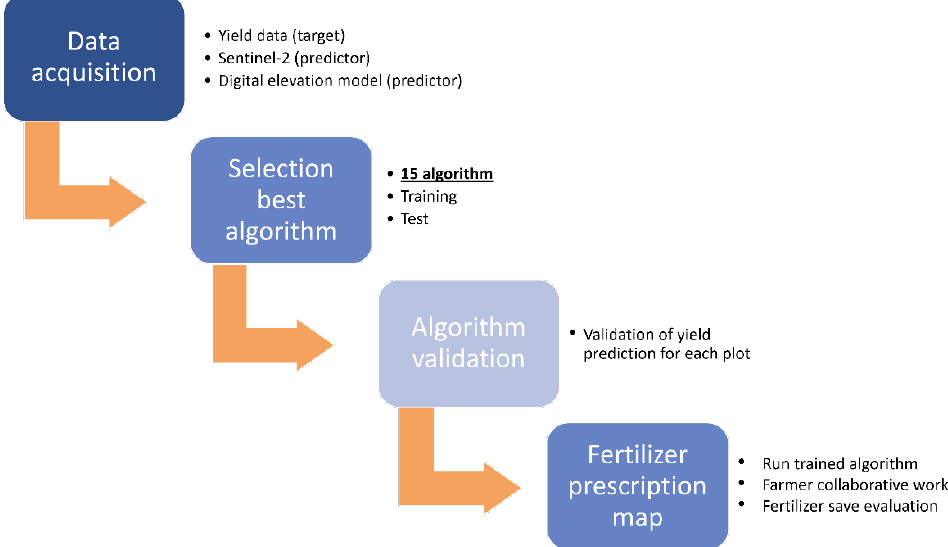
Figure 2. Flowchart of the proposed working methodology to obtain a fertilizer prescription map in one agricultural plot without yield data.